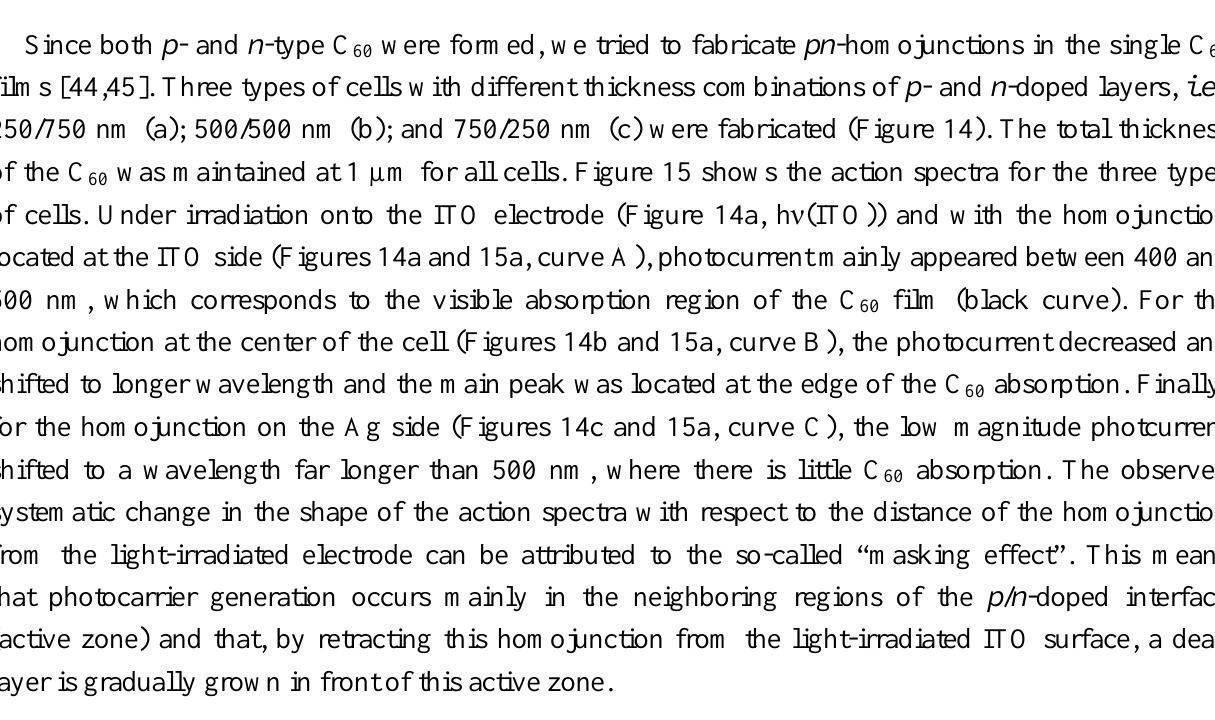
:Cs CO (10:1) (right). 60 2 3 formation 60